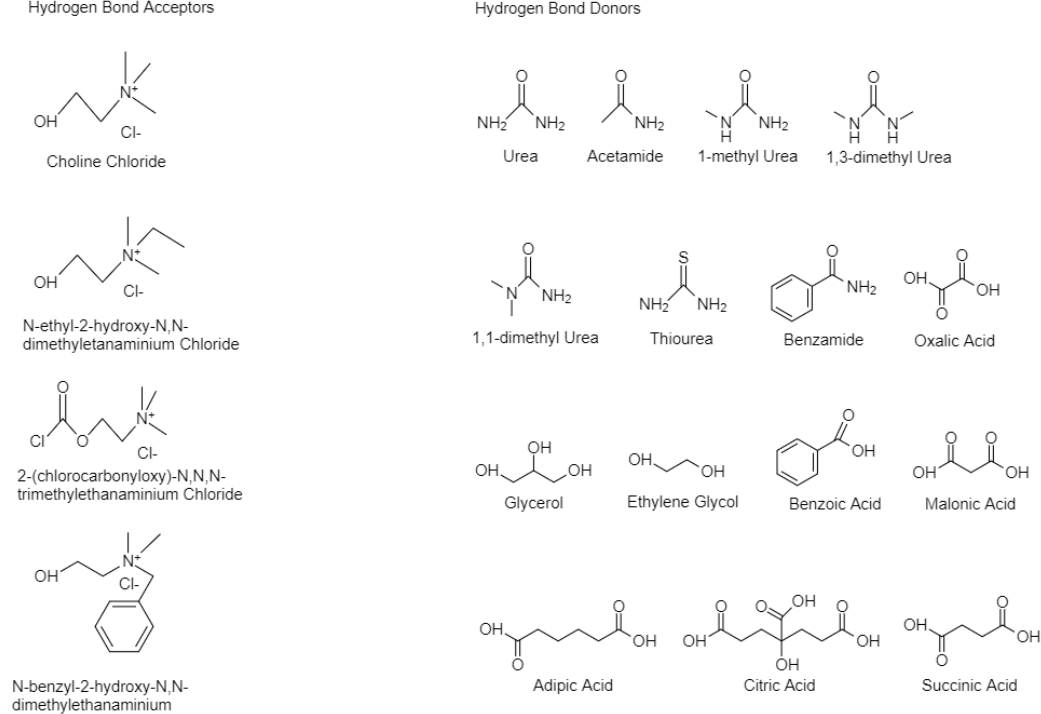
Figure 1. Structures of some halide salts (HBAs) and hydrogen bond donors (HBDs) used in the formation of deep eutectic solvents.